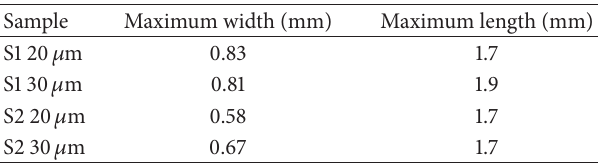
Table 5: Estimated maximum width and maximum length of the area caused by peeling damage in samples S1 and